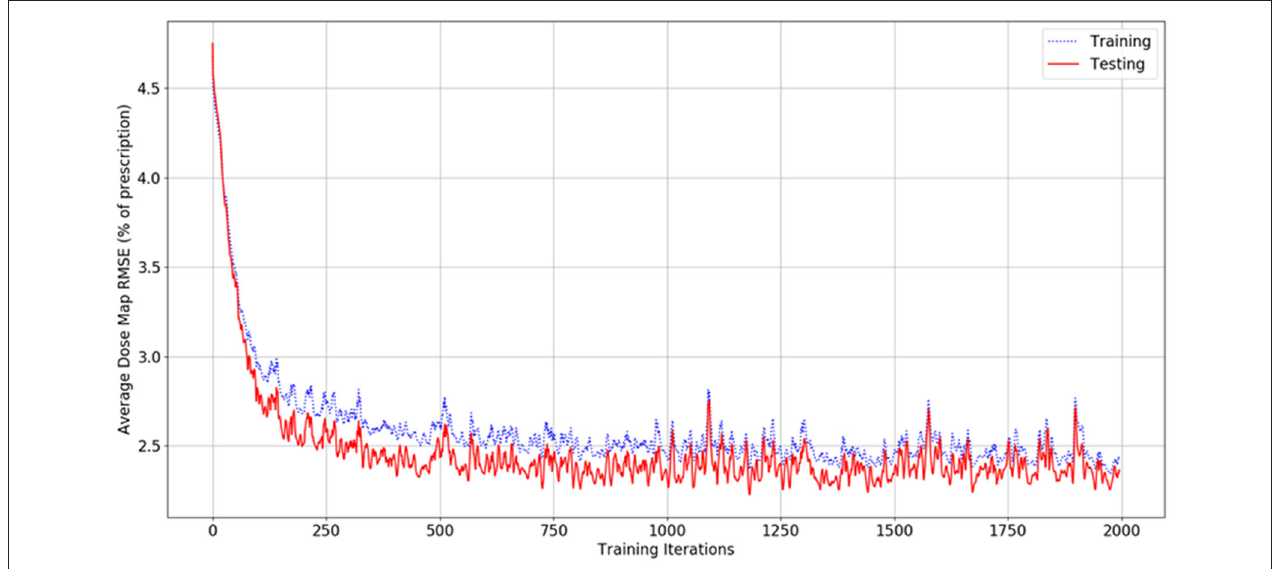
FIGURE 4 | Graph of dose map root-mean-square error for the training set (blue, dashed) and testing set (red, solid) as a function of the number of iterations during model training.